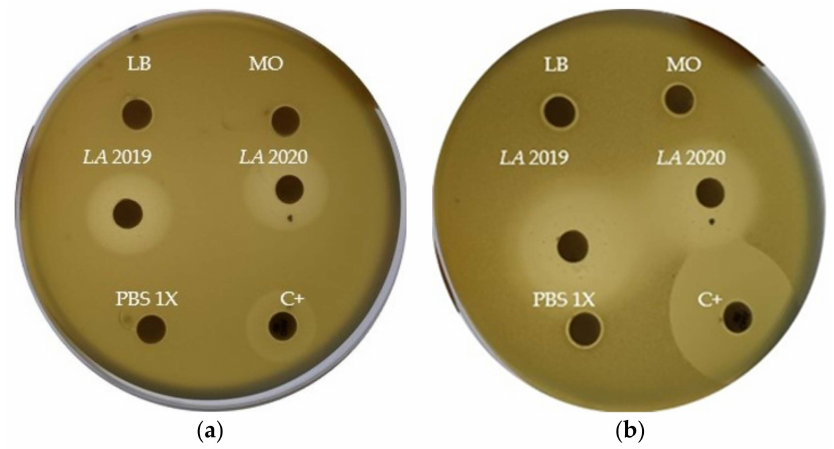
Figure 6. Zones of growth inhibition (halos) of E. coli DH5 α ( a ) and B. subtilis PY79 ( b ) in the presence of 10 µ L of LA 2019 and LA 2020 EOs. We used 10 µ L of LB broth (LB), 10 µ L of mineral oil (MO) and 10 µ L of PBS 1X as negative controls, and amoxicillin (20 µ g) + clavulanic acid (10 µ g) as positive control (C+).